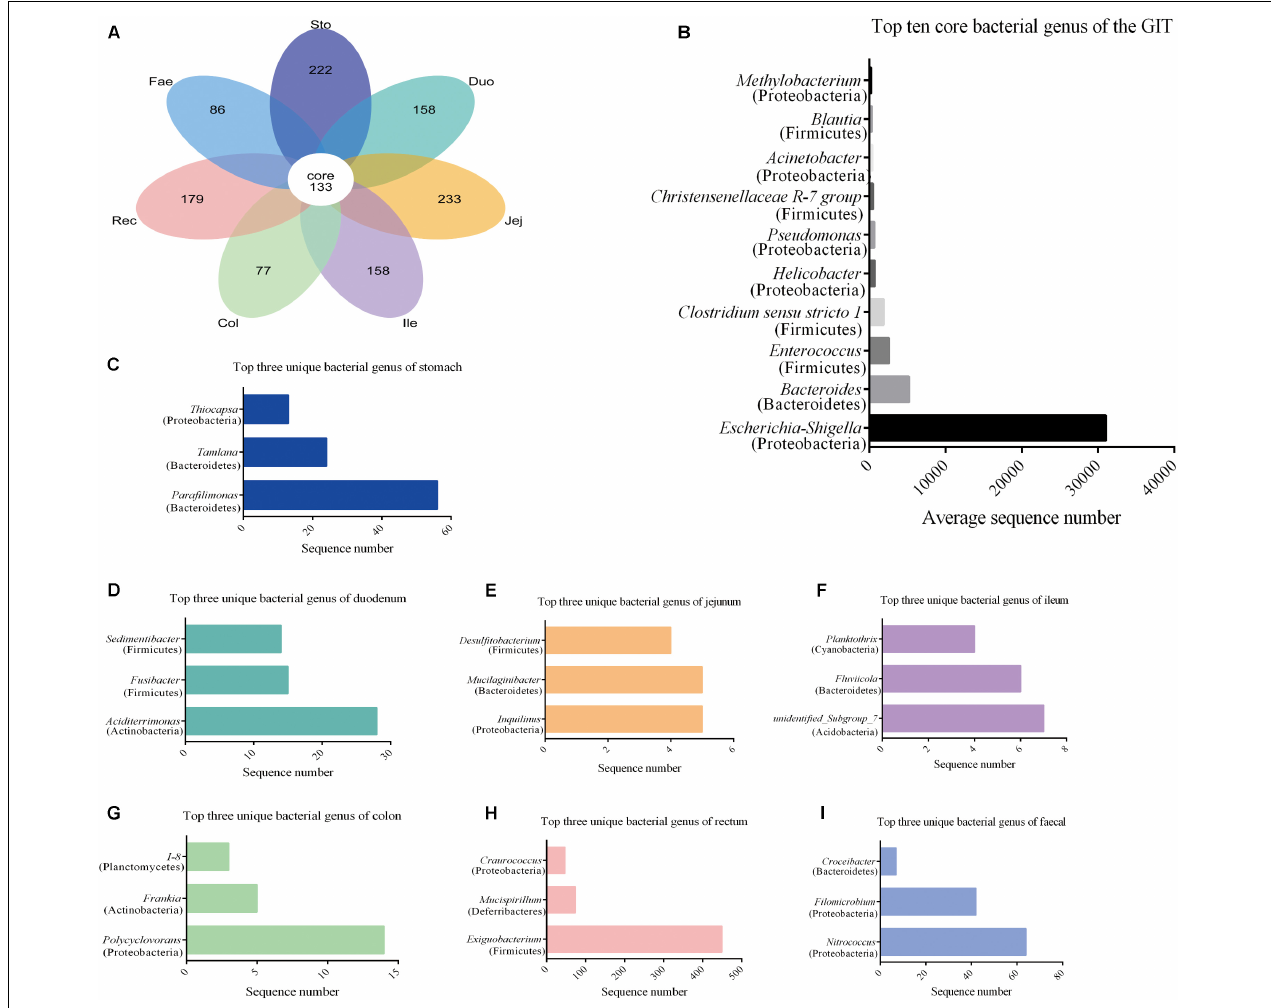
FIGURE 3 | Core and unique microbiota in red panda GIT. (A) The venn petal diagrams of the bacterial community in GIT. (B) Top 10 core bacterial genera of all the segments. (C–I) Top three unique bacterial genera in samples from the stomach, duodenum, jejunum, ileum, colon, rectum, and faecal,